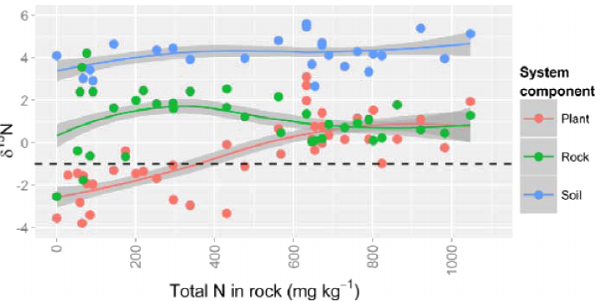
Figure 2. δ 15 N of live foliage, soil, and parent material (rock) vs. rock N concentrations across Douglas fir forest. The dashed line reflects the δ 15 N of atmospheric N inputs (Morford and Houlton,